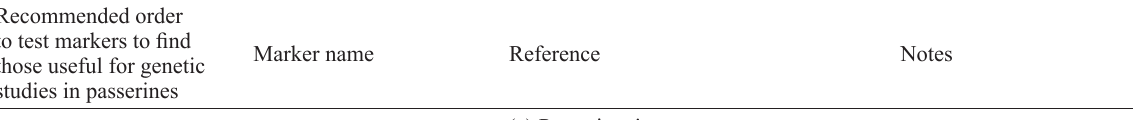
Ranking of the most useful microsatellites markers for genetic studies of passerines and non-passerines, selected according to their cross-utility in multiple